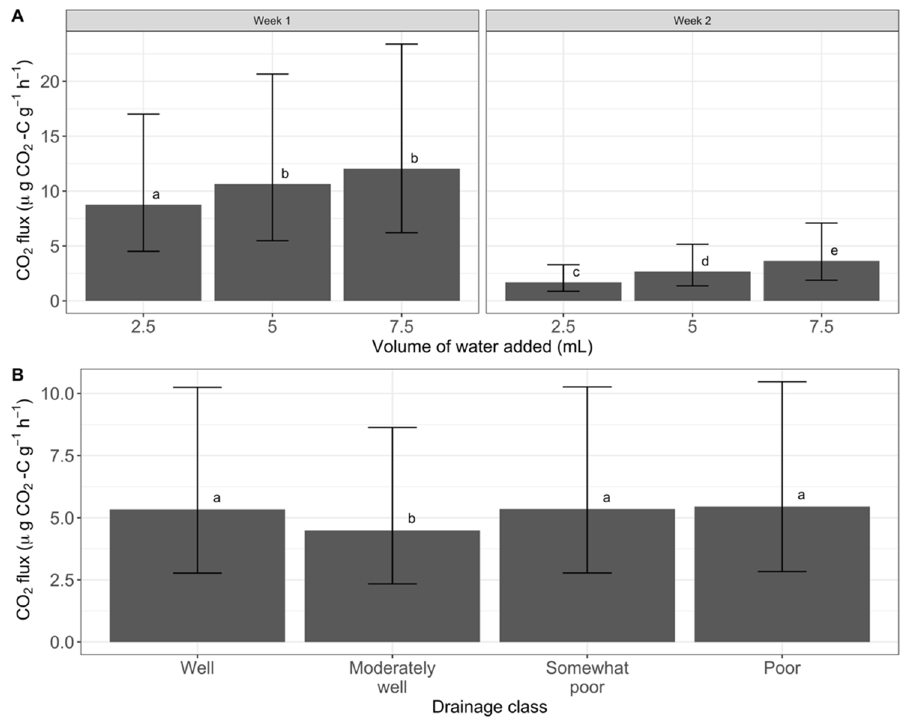
Figure 5. The least square mean values of the CO 2 flux for pairwise comparisons of the volume of water (soil moisture status) added by week are shown in panel ( A ). The least square means of CO 2 flux by drainage class are shown in panel ( B ). Letters represent significant differences ( p -value < 0.05). Error bars represent 95% confidence intervals.